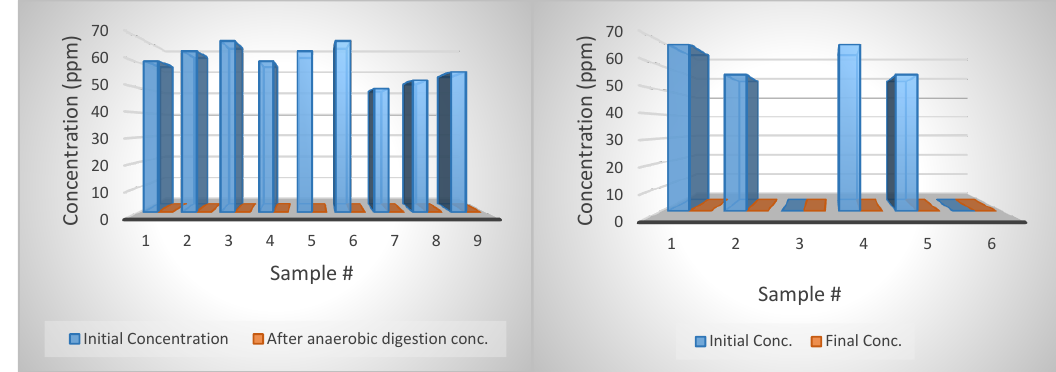
Figure 8. Left : CTC concentration change with anaerobic digestion. Right : CTC concentration change with reactors filled with diluted water.